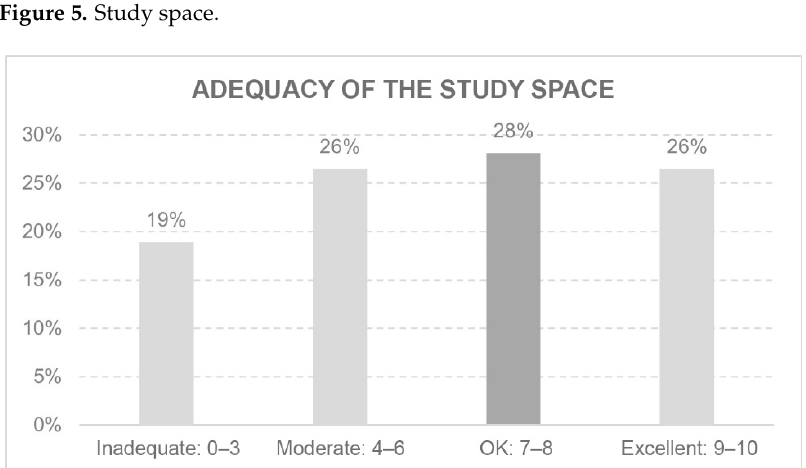
Figure 5. Study space.